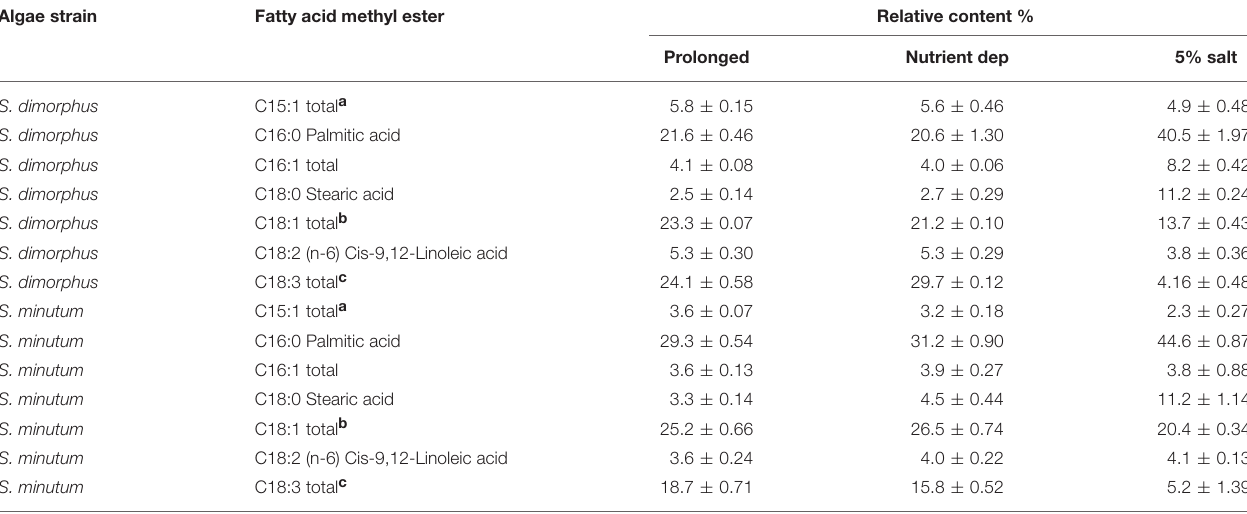
TABLE 2 | Composition of fatty acid methyl esters (FAMEs) obtained from S. dimorphus and S. minutum . Algae strain Fatty acid methyl